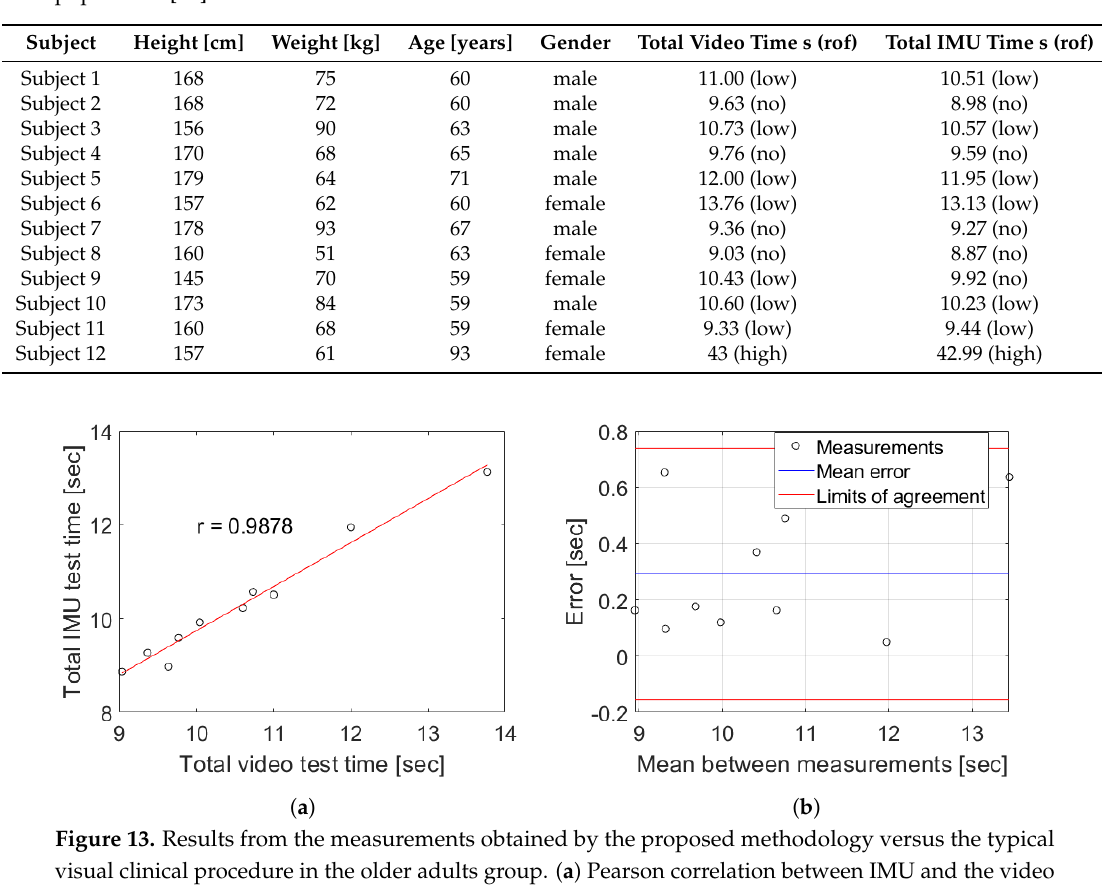
Table 3. Results from the measurements obtained by the proposed methodology versus the typical visual clinical procedure in the older adults group, where rof = risk of falling, high = high risk of falling, low = low risk of falling and no = no risk of falling. The classification of the risk of falling of the subjects was obtained by following the manual of the ministry of health (MINSAL) for the Chilean population [28].